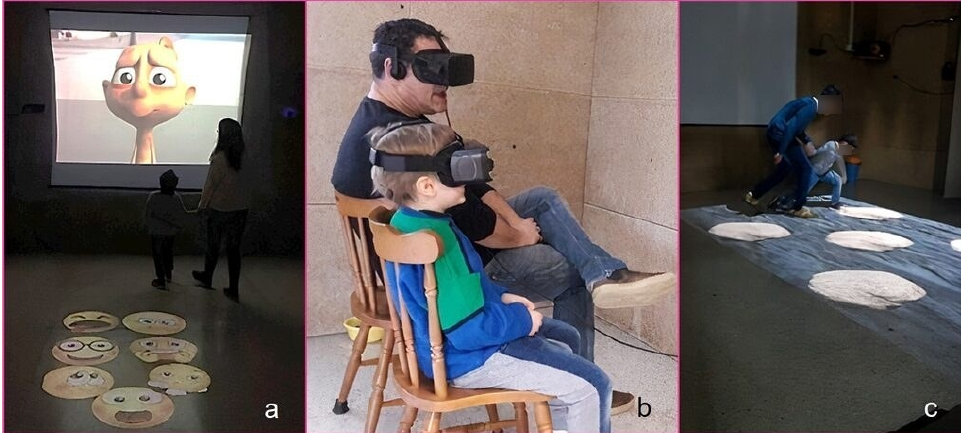
Figure 1. (From left to right) Therapists guiding children through ( a ) emotion recognition activity, ( b ) immersive virtual exposure to daily life abilities (i.e., taking the bus), and ( c ) adaptation of a Walking Corsi test for visuo-spatial working memory.